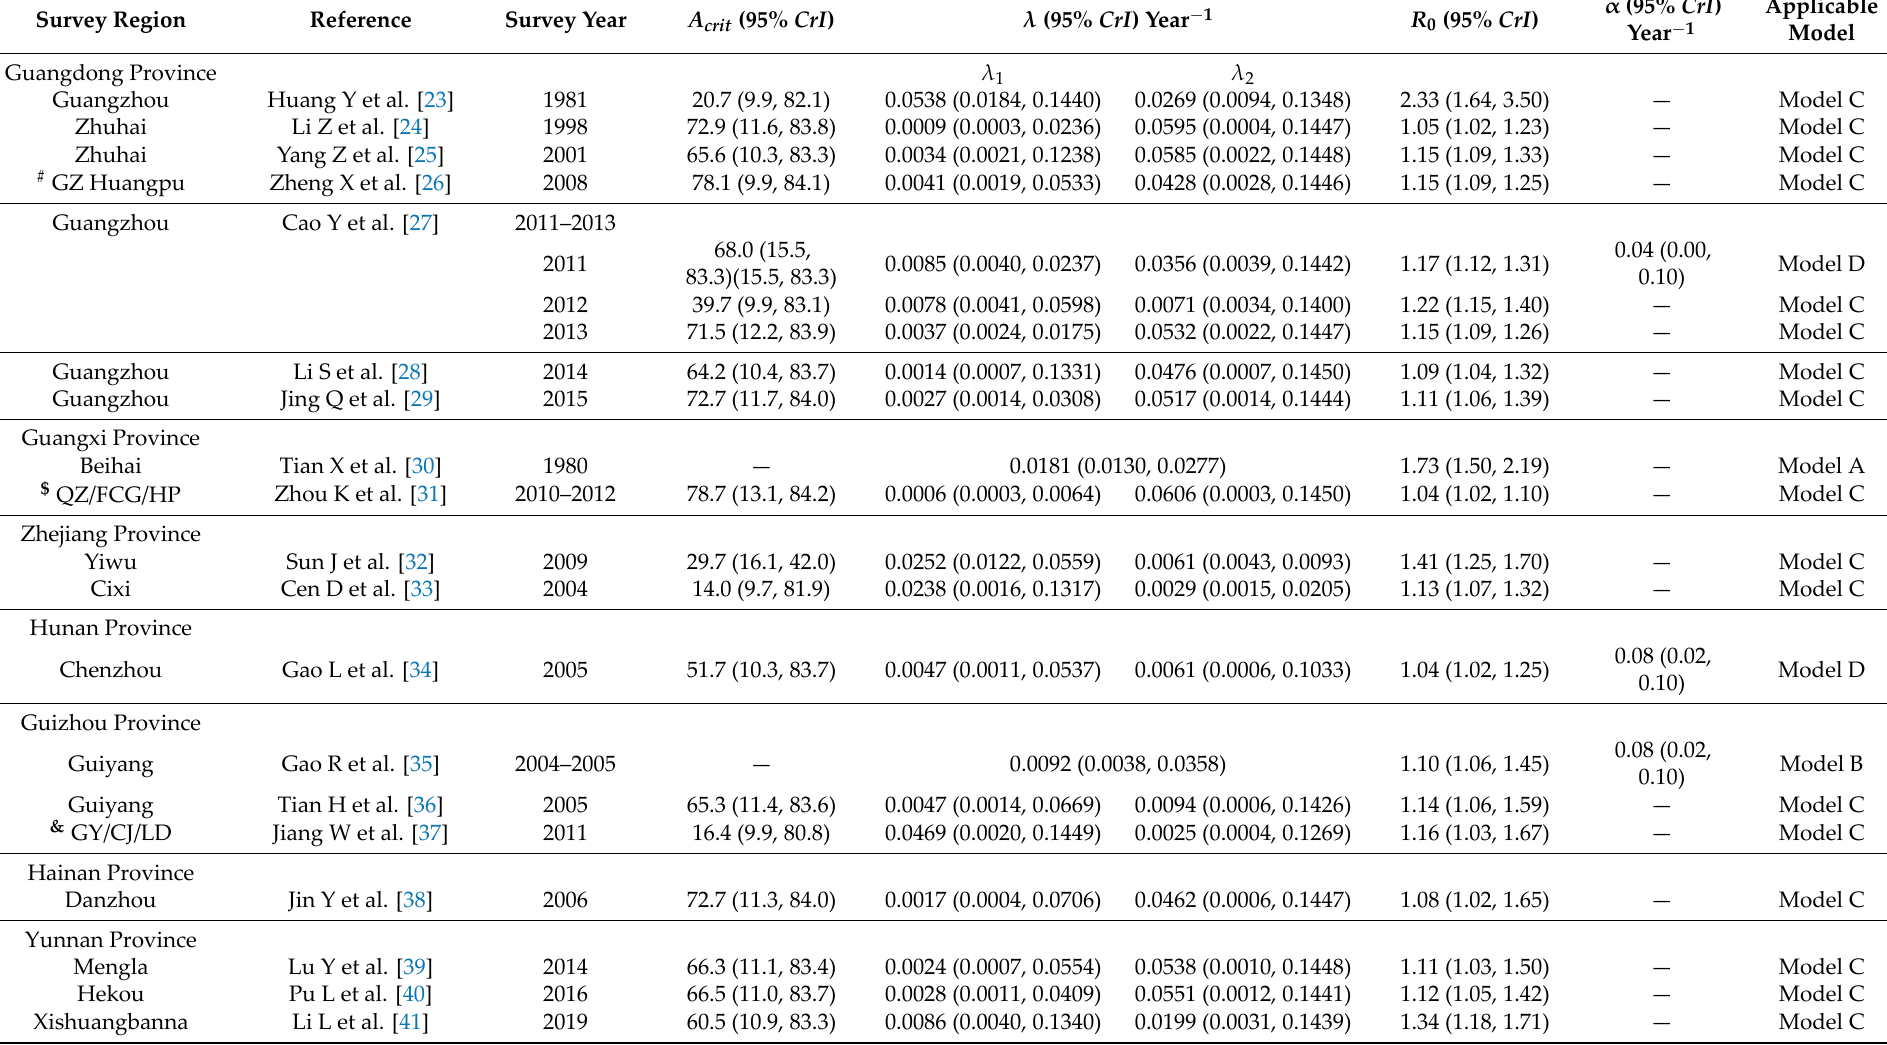
Table 2. Summary of estimation results from the best model fitting to 31 data